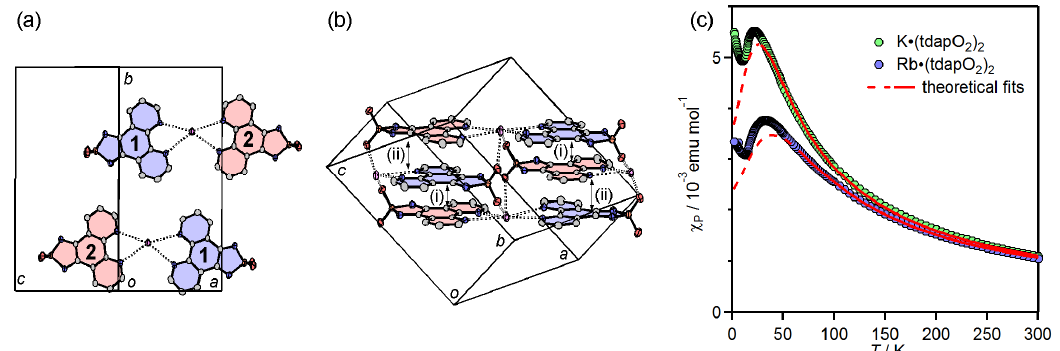
) and temperature dependence of χ 2 2